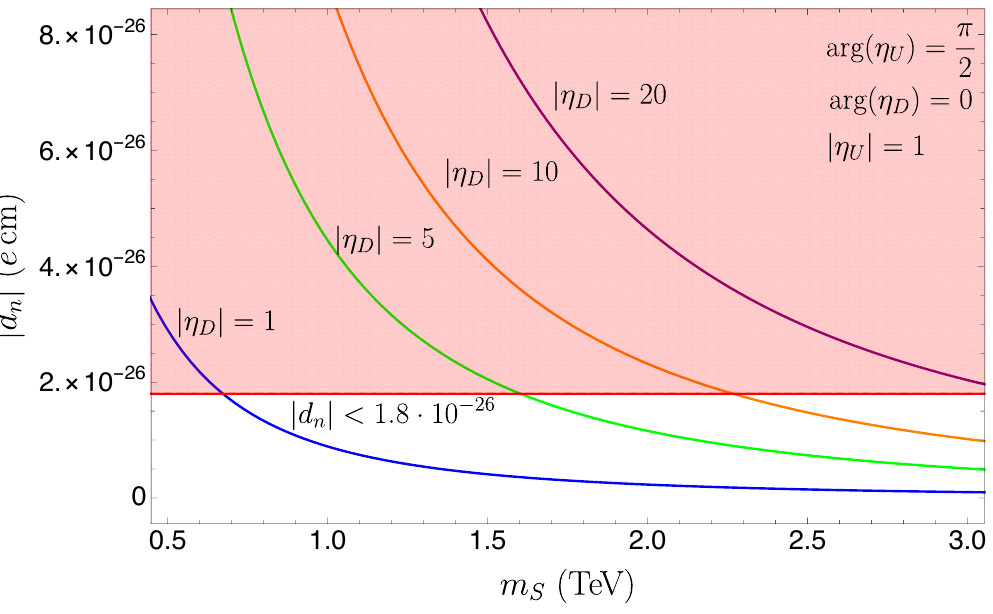
Figure 10 . Electric dipole moment of the neutron as a function of the mass of the coloured scalars, m S (all scalar masses are fixed to the same value). The shaded region is excluded by the current experimental